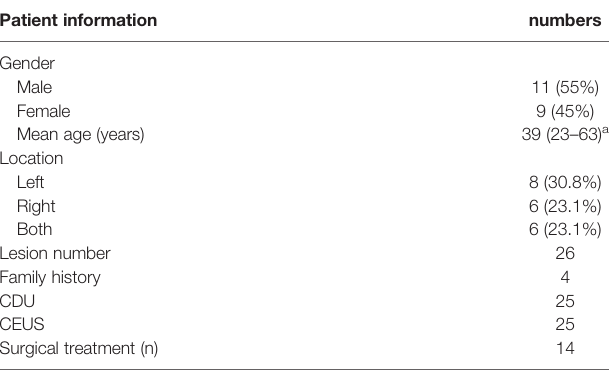
TABLE 1 | CBT patient characteristics.